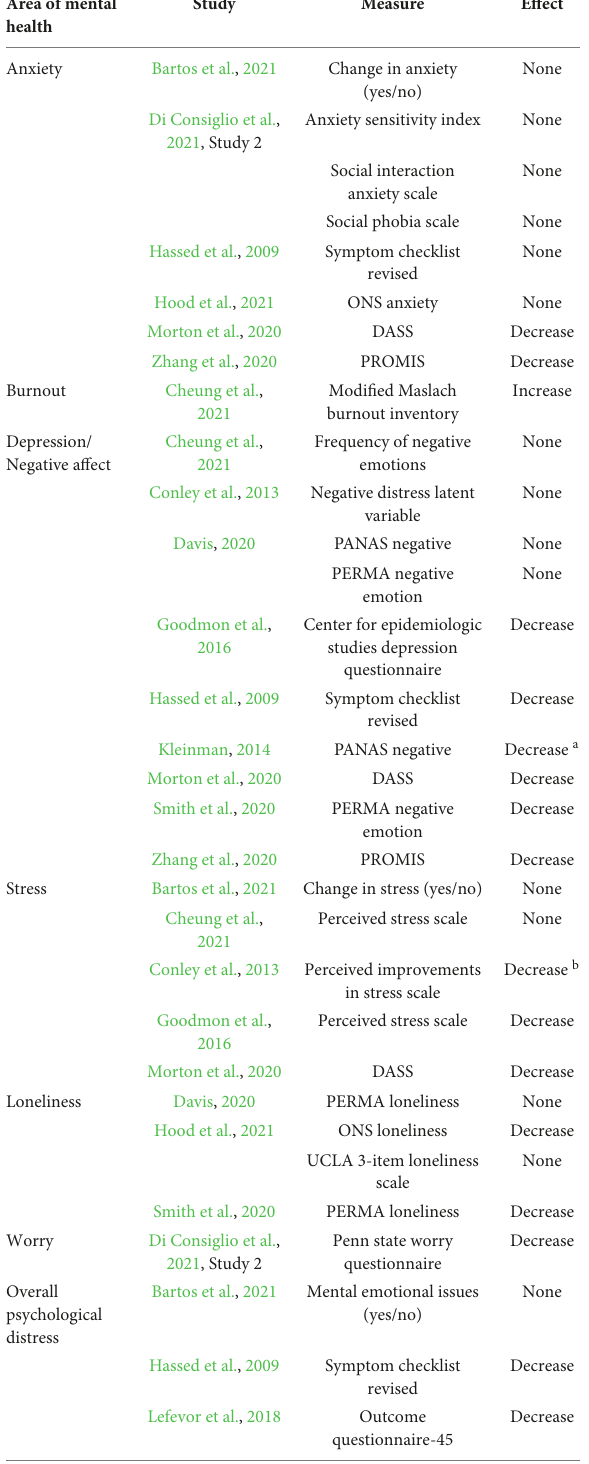
TABLE 2 Summarized effects of positive psychology courses on measures relating to mental